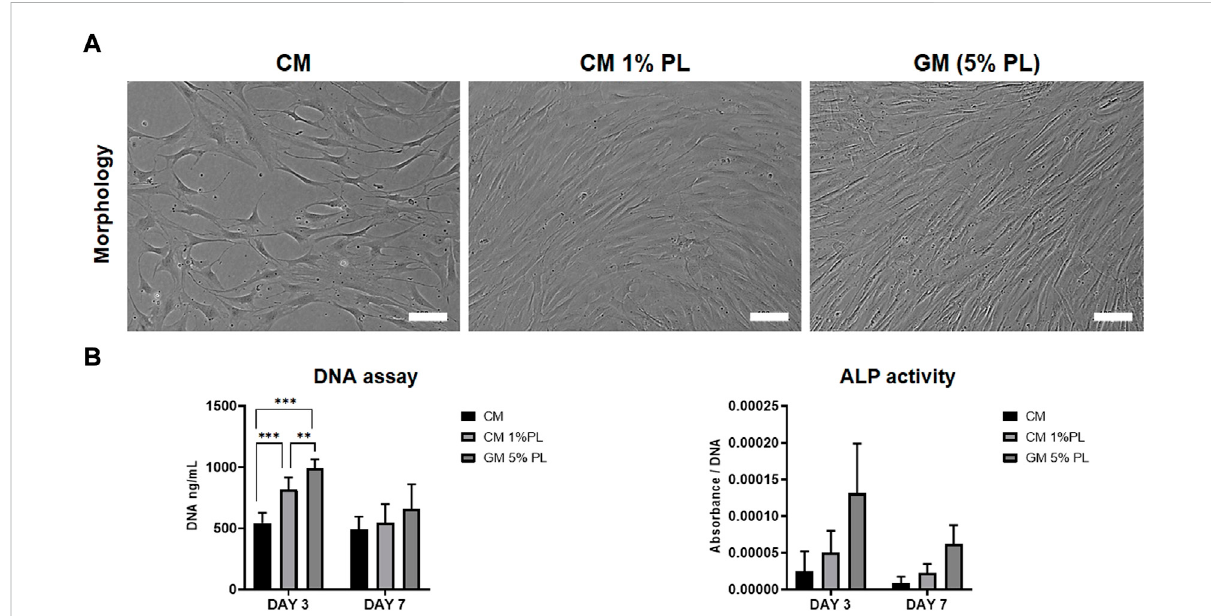
FIGURE 1 Proliferation and ALP activity. (A) Representative images of BMSC cultured in CM, CM supplemented with HPL (1% PL) or growth media (5% PL; control)after3 days,scalebars100 μ m. (B) Quanti fi cationoftotalDNA( fl uorescence)andALPactivity(absorbance)inBMSCculturedinCM,CM+1% PL and GM after 3 and 7 days ( n = 2 donors; 3 experimental replicates per donor); ** p < 0.005, *** p <